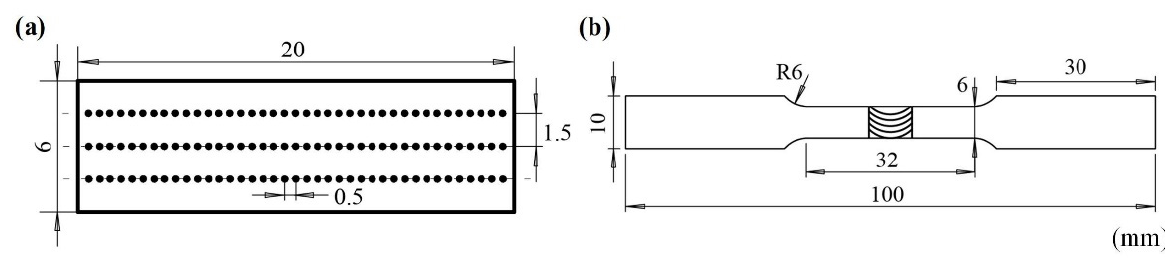
Figure 2. Schematics of ( a ) microhardness test sample and ( b ) tensile test sample. 3. Results 3.1. Macrostructures of the Joints Figure 3 presents the surface morphologies of AA6061 Al/AZ31B Mg dissimilar joints fabricated via FSW and SFSW. As shown in Figure 3a,b, obvious galling and groove de- fects could be observed on the FSW joint while SFSW obtained a smooth weld surface at